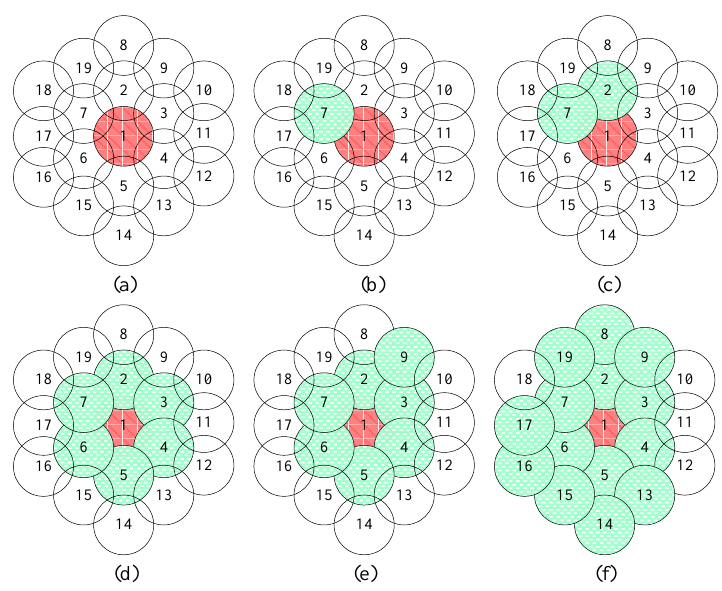
Figure 3. An example of dynamic cooperating set planning.